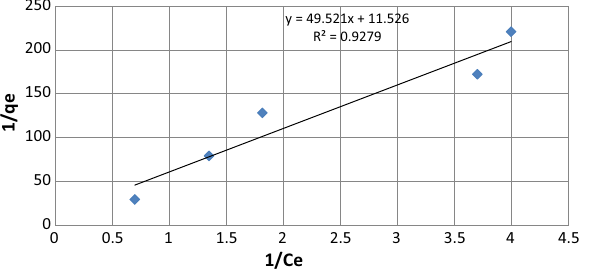
C e and 1/ e of Langmuir equation for